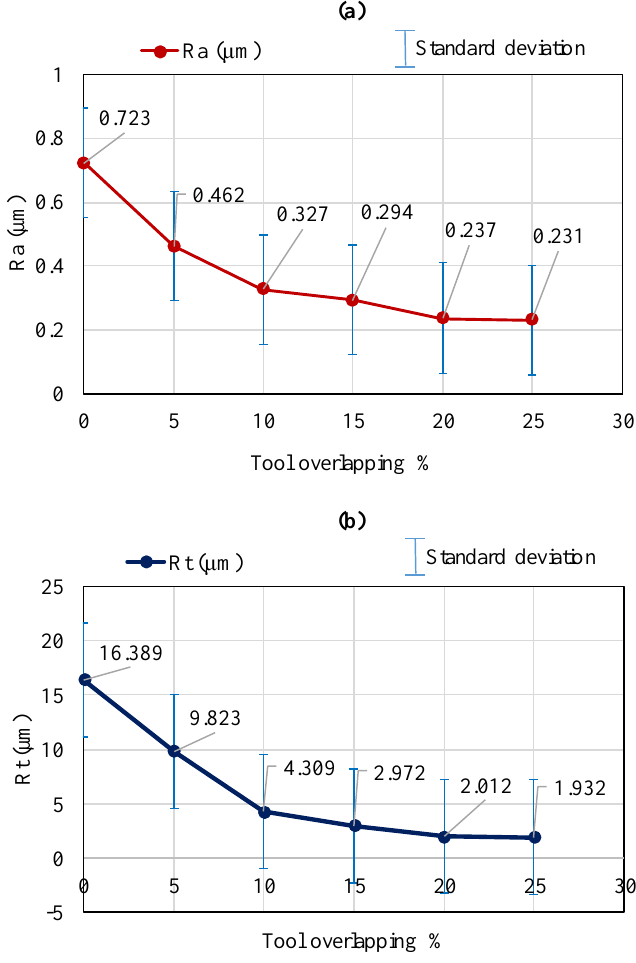
ff ects of tool overlapping on ( a ) Ra and ( b ) Figure 7. Effects of tool overlapping on ( a ) Ra and ( b ) Rt. Figure 7. E